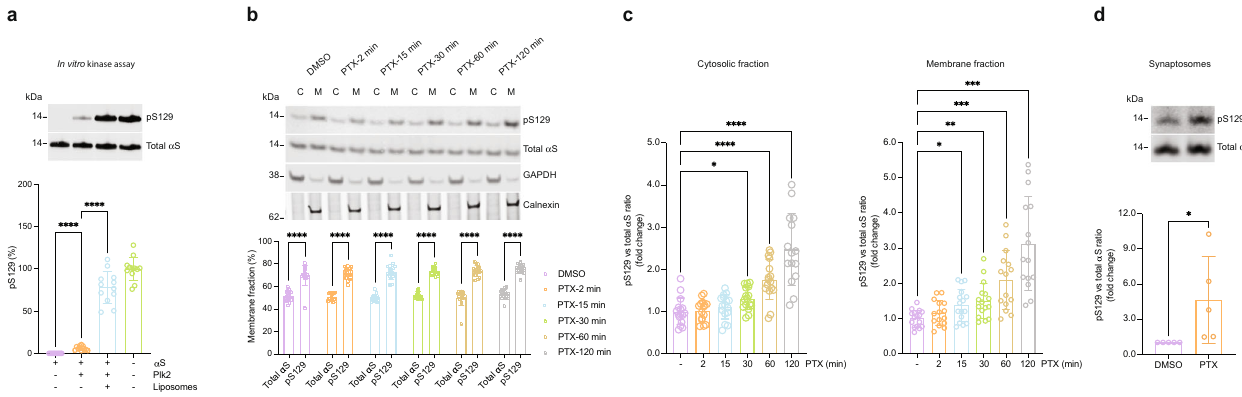
Fig. 4 Activity-induced pS129 is enriched in membrane fractions. a In vitro kinase assay was carried out by incubating 2 µM recombinant α S alone, α S + 2 µM Plk2, and α S + Plk2 + 0.2 mM liposomes. N = 3 independent experiments on different days, n = 12 biological replicates total; **** p < 0.0001. Mean + / − SD. RM one-way ANOVA with post hoc Sidak ’ s multiple comparisons test. b DIV18-20 rat cortical neurons treated with 20 µM PTX for the indicated time points and subjected to sequential extraction to generate cytosol (C) vs. membrane (M) protein lysates. WB for total α S and pS129. Quanti fi cation of total α S and pS129 in membrane fractions. N = 4 independent experiments on different days, n = 16 biological replicates total. **** p < 0.0001. Mean + / − SD. Two-way ANOVA with post hoc Tukey ’ s multiple comparisons test. c Samples as in b . Quanti fi cation of total α S vs pS129 ratios as indicated in cytosolic and membrane fractions, respectively. * p < 0.05; ** p < 0.01; *** p < 0.001; **** p < 0.0001. Mean + / − SD. Brown-Forsythe and Welch ANOVA with Dunnett ’ s T3 post hoc test for multiple comparisons. d DIV18-21 rat cortical neurons treated with DMSO or 20 µM PTX followed by isolation of synaptosomes. WBs for total α S and pS129. N = 6 independent experiments on different days. * p < 0.04. Mean + / − SD. Ratio paired t -test;